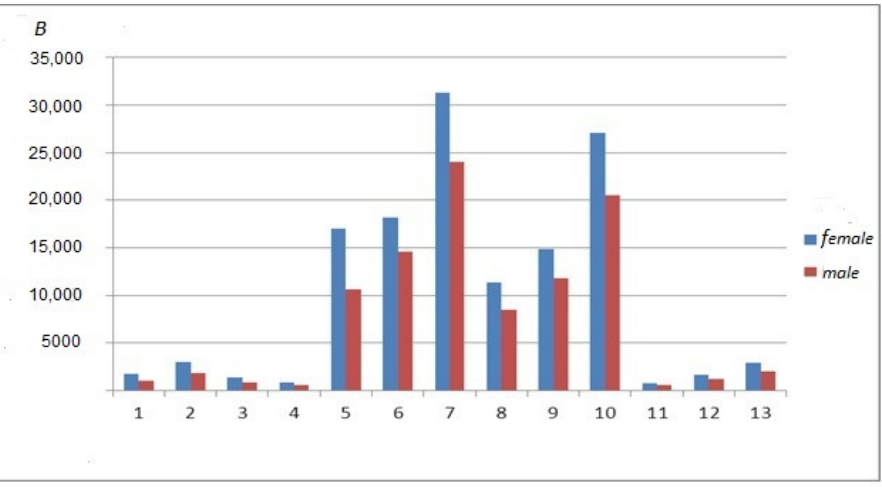
Figure 5. Gross premium size as a function of the accumulation period.